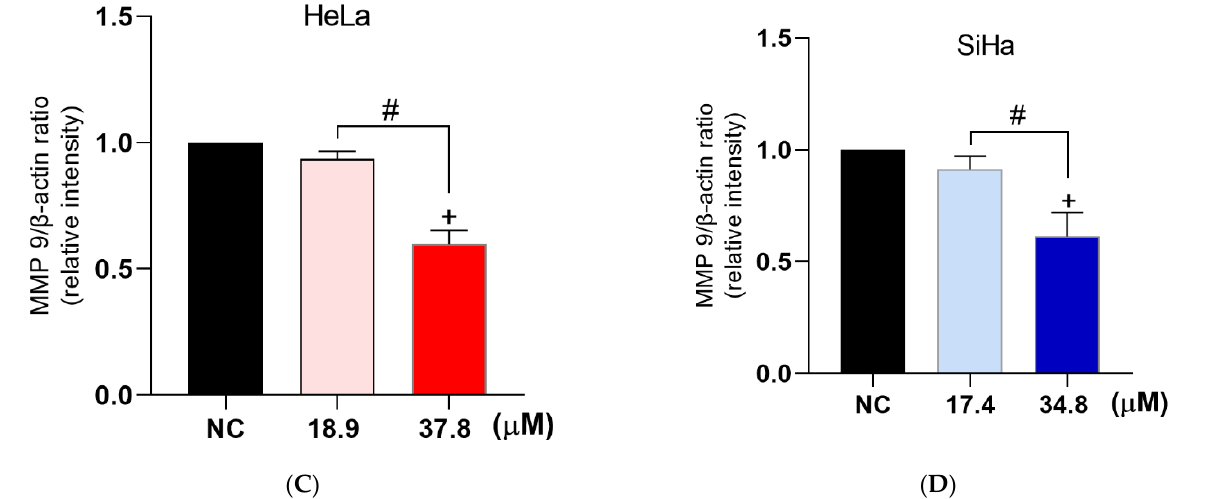
Figure 12. Effects of A3K2A3 on cell metastasis. Analysis of cell migration ( A ) HeLa and ( B ) SiHa. Evaluation of MMP-9 expression ( C ) HeLa and ( D ) SiHa. Cells were treated with A3K2A3 (IC 50 or 2xIC 50 ) for 24 and 48 h for analysis of cell migration and only 48 h for evaluation of MMP-9 expres- sion. The photos were taken using an Olympus CKX41 inverted phase contrast microscope (4× mag- nification; scale bar: 200 μm) and the percentage of cell growth in the wound r egion was calculated using ImageJ software ( A , B ). The antigen-antibody complex was detected by chemiluminescence employing ECL detection reagent and analyzed using ChemiDoc ® XRS+ Imaging System, and the protein levels were determined by normalization with β -actin ( C , D ). ( A ) HeLa and ( B ) SiHa; NC (a, b, c), IC 50 at 0, 24, and 48 h (d, e, f) and 2xIC 50 at 0, 24, and 48 h (g, h, i). The data represent the percentage of wound closure ± SD of three independent experiments that were performed in tripli- cate. * p < 0.05 compared to 24 h NC, + p < 0.05 compared to 48 h NC (two-way ANOVA followed by Tukey ’ s post-test). ( C ) HeLa and ( D ) SiHa; data represent the mean ± SD of three independent experiments that were performed in triplicate. + p < 0.05 compared to 48 h NC, # p < 0.05 significant difference between A3K2A3 concentrations (one-way ANOVA followed by Tukey ’ s post-test).